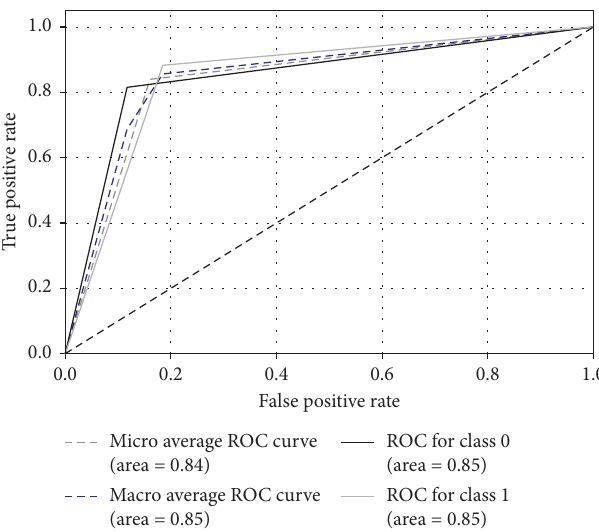
Figure 7: ROC curve for testing data using KNN model.